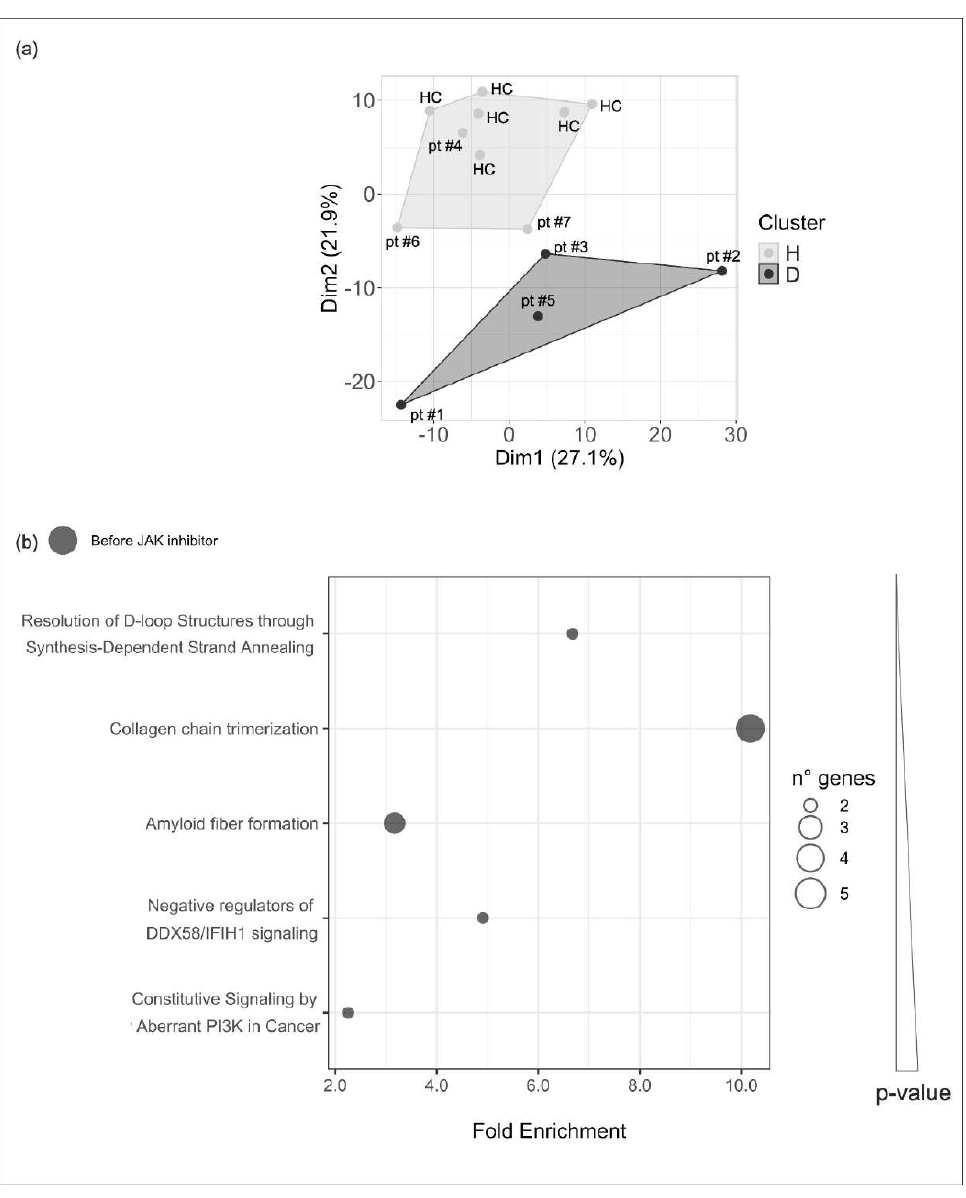
Figure 2. Cluster analysis and pathway enrichment. ( a ) Cluster analysis results (K-means clustering) considering 500 most variable protein-coding genes across all samples that divide subjects into subgroups by similarities. Each dot represents a subject; Dim1 and Dim2 show the higher di ff erences between the main clusters; H-Cluster contains all the healthy control-group subjects (HC) and some patients (pt) a ff ected with multifactorial disorders. D-Cluster contains mainly subjects with proven or suspected rare monogenic disorders. ( b ) Pathway analysis was run on di ff erential expressed genes resulting from the comparison between the seven patients and the control-group subjects: each dot represents a pathway and the size is directly proportional to the number of genes. X -axis reports pathway fold enrichment. All the selected pathways showed a lowest adjusted- p -value of the given term over all iterations ≤ 0.01. Pathway are listed by increasing p